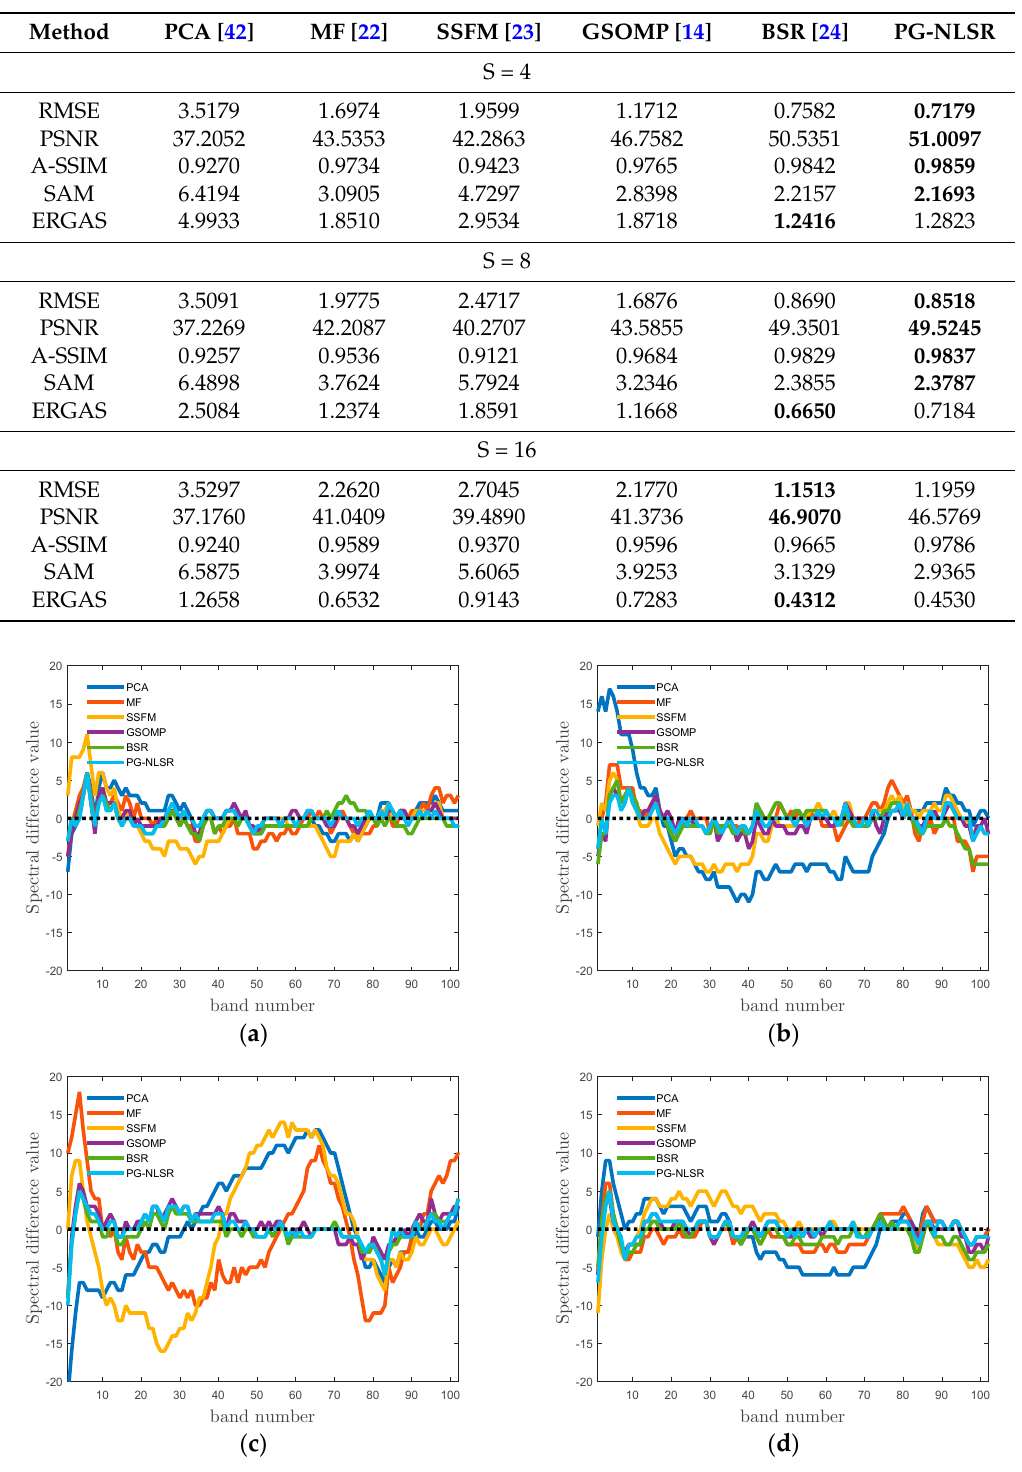
Table 3. Evaluation assessments for Pavia University HSI over different scale factors.